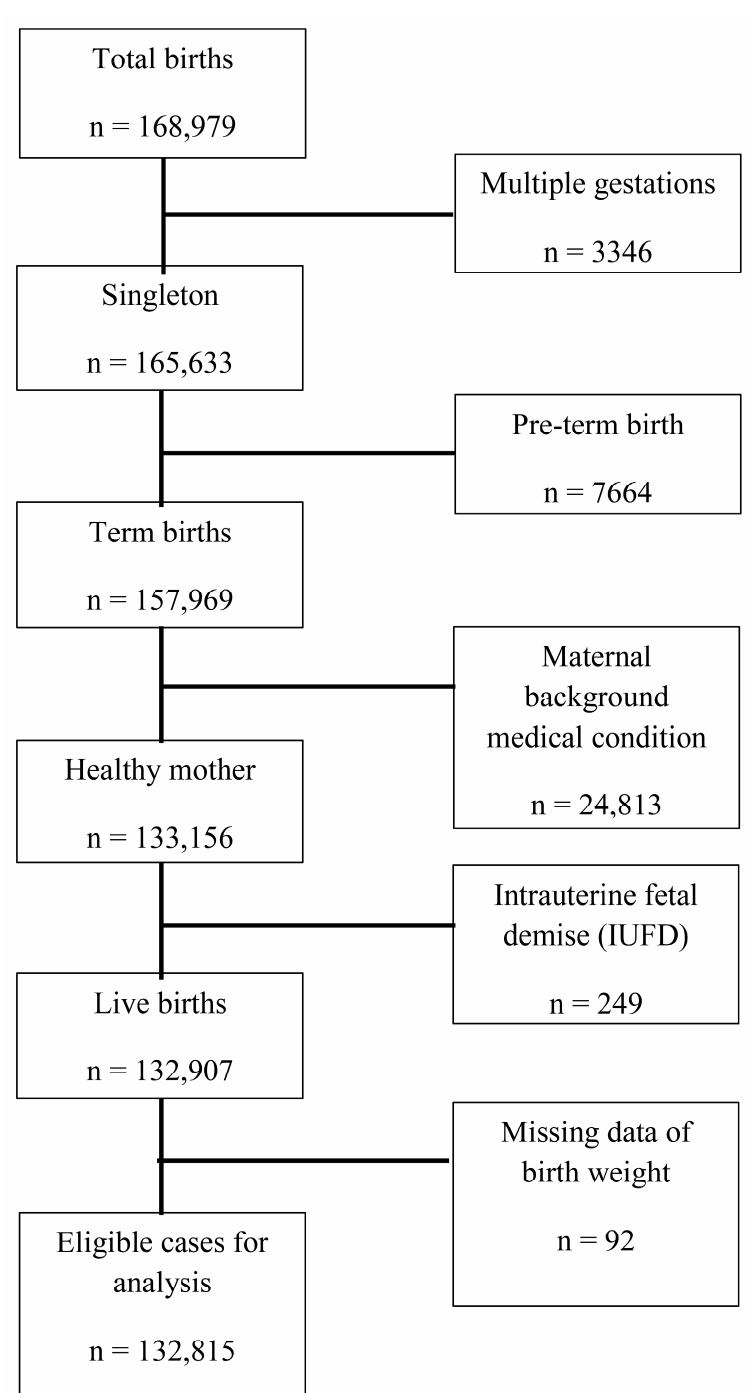
Figure 1. Study population flowchart. Calculation of mean birth weight for each maternal parity group demonstrated a progressive increase in birth weight from a mean of 3220 gr ± 405 for primiparas up to a mean birth weight of 3498 ± 450 for parity group ≥ 10 ( p < 0.001, Figure 2).